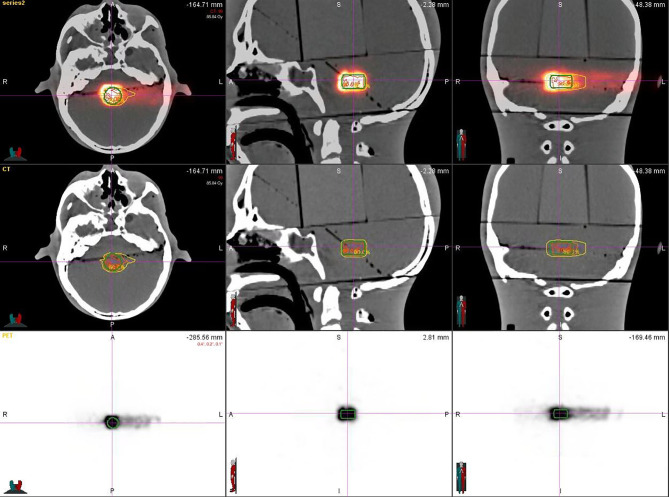
Rando head phantom PET/CT scanning.